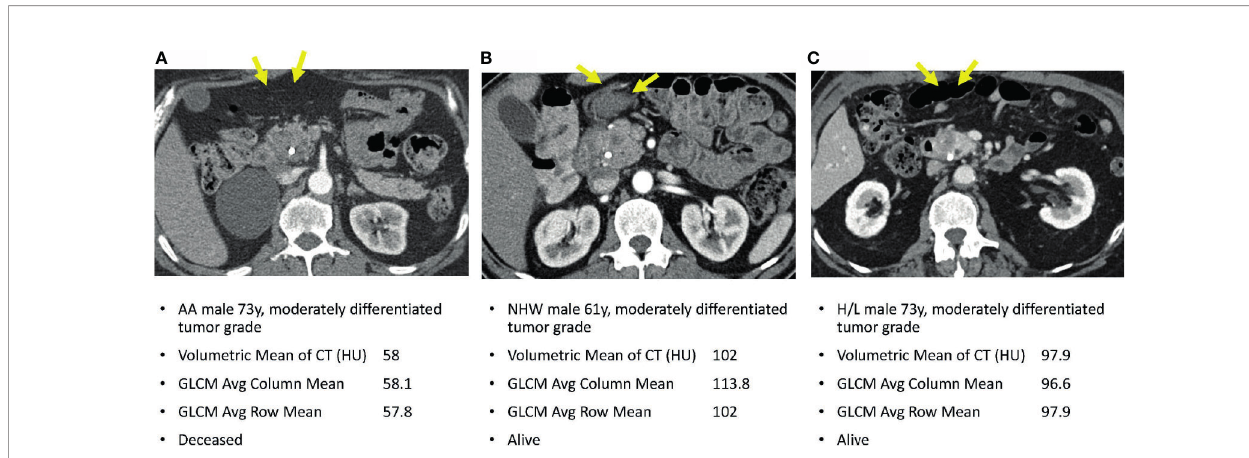
FIGURE 4 | Axial venous phase CT images are presented in PDAC patients matched for tumor grade, gender, and age-group. Image (A) from an AA patient and shows a poorly de fi ned hypoenhancing tumor marked by the yellow arrows. Image (B) in a NHW shows a similar radiologic appearance of the tumor but with signi fi cantly different radiomic tumor values. Image (C) in a Hispanic patient also had radiomic values different from the AA case. Note that a common bile duct stent is present in each of these patients.